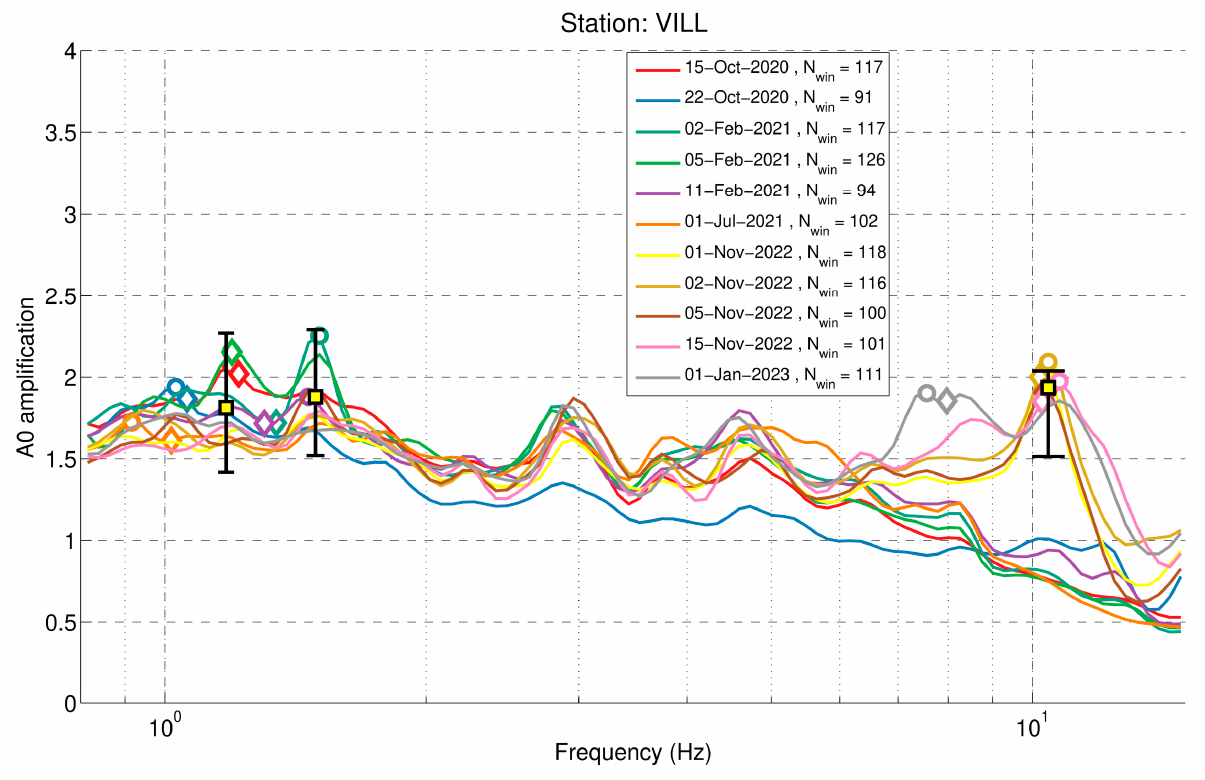
Figure 7. Average HVSR curves (solid lines) determined for station VILL on different days, from 60 s long windows selected after the application of STA/LTA anti-triggering on 6 h long records. Circles denote the global frequency on each curve, while diamond symbols mark the average of the frequency band denoting the range of peak frequencies of the HVSR lines from the individually selected windows (light/dark gray band in Figure 2b). Squares mark the prominent global and secondary peak frequencies recognized from the HVSR spectra, with error bars indicating the uncertainty of the amplification factor (Table A1).